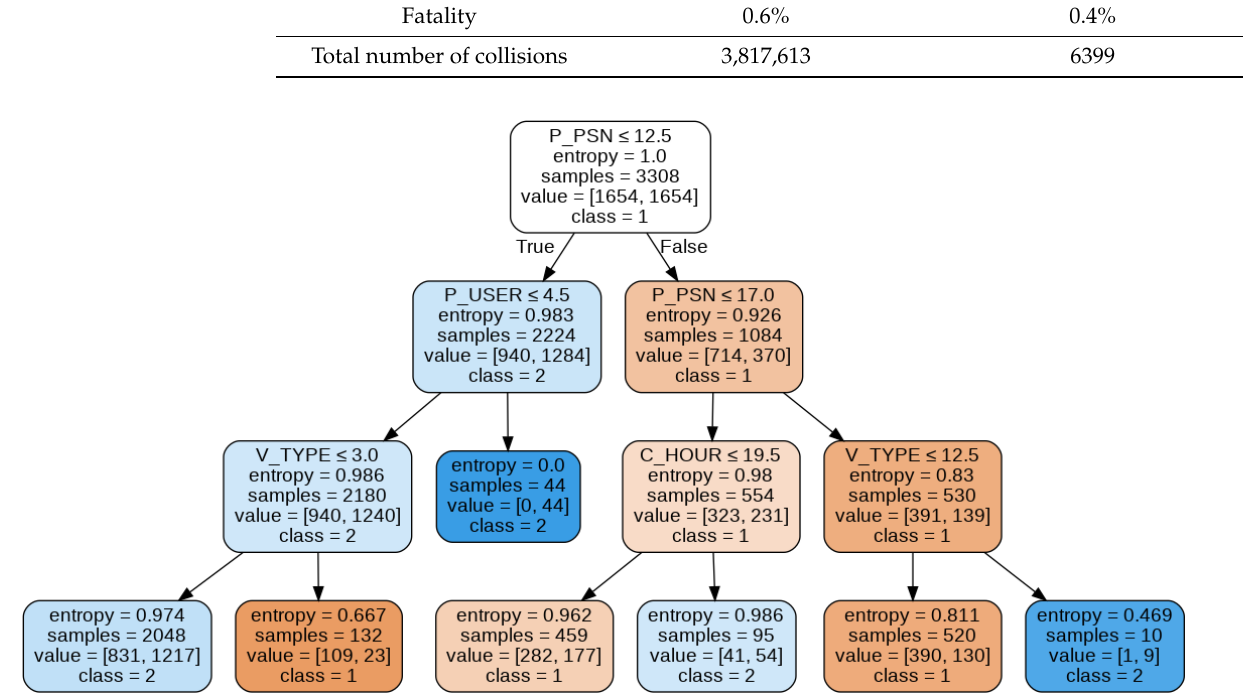
Figure 3. Decision tree.